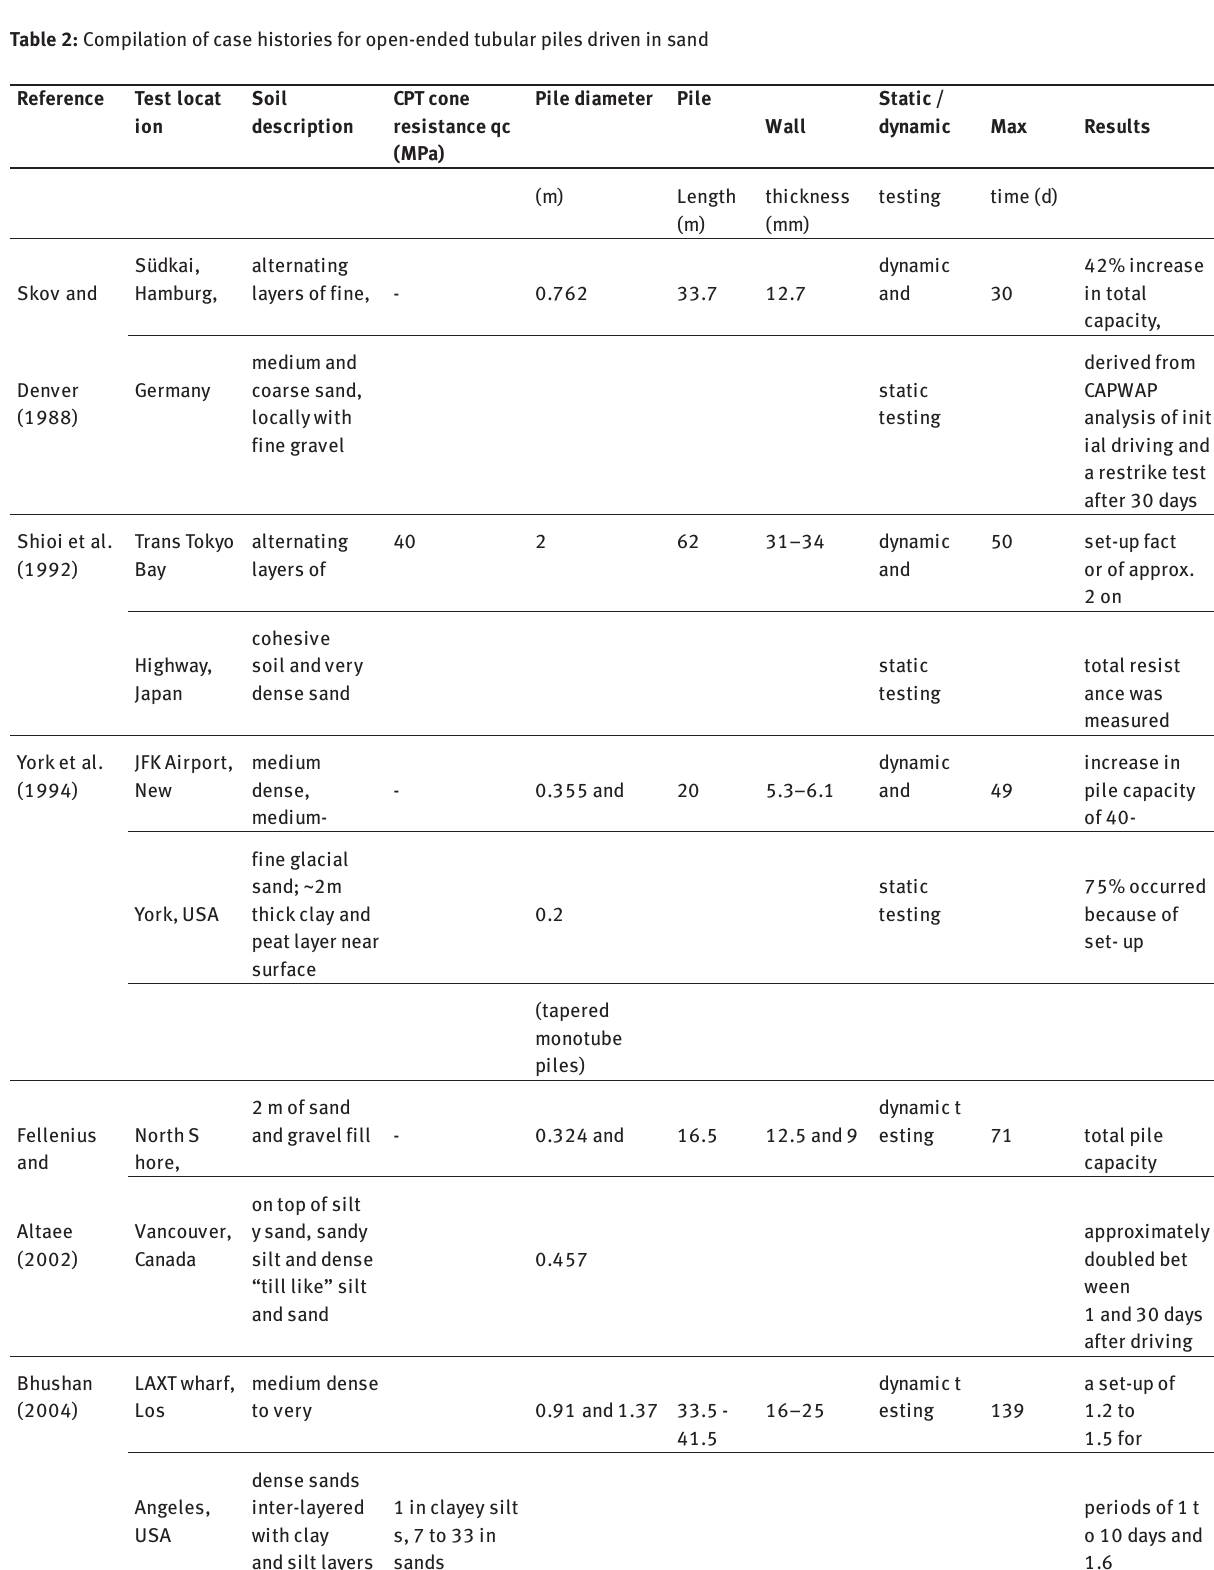
Table 2: Compilation of case histories for open-ended tubular piles driven in sand